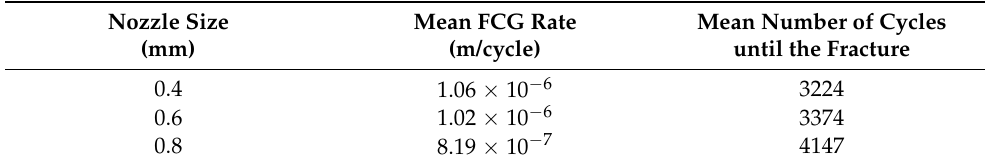
Table 7. The mean FCG rate and number of cycles of different nozzle sizes regardless of other printing